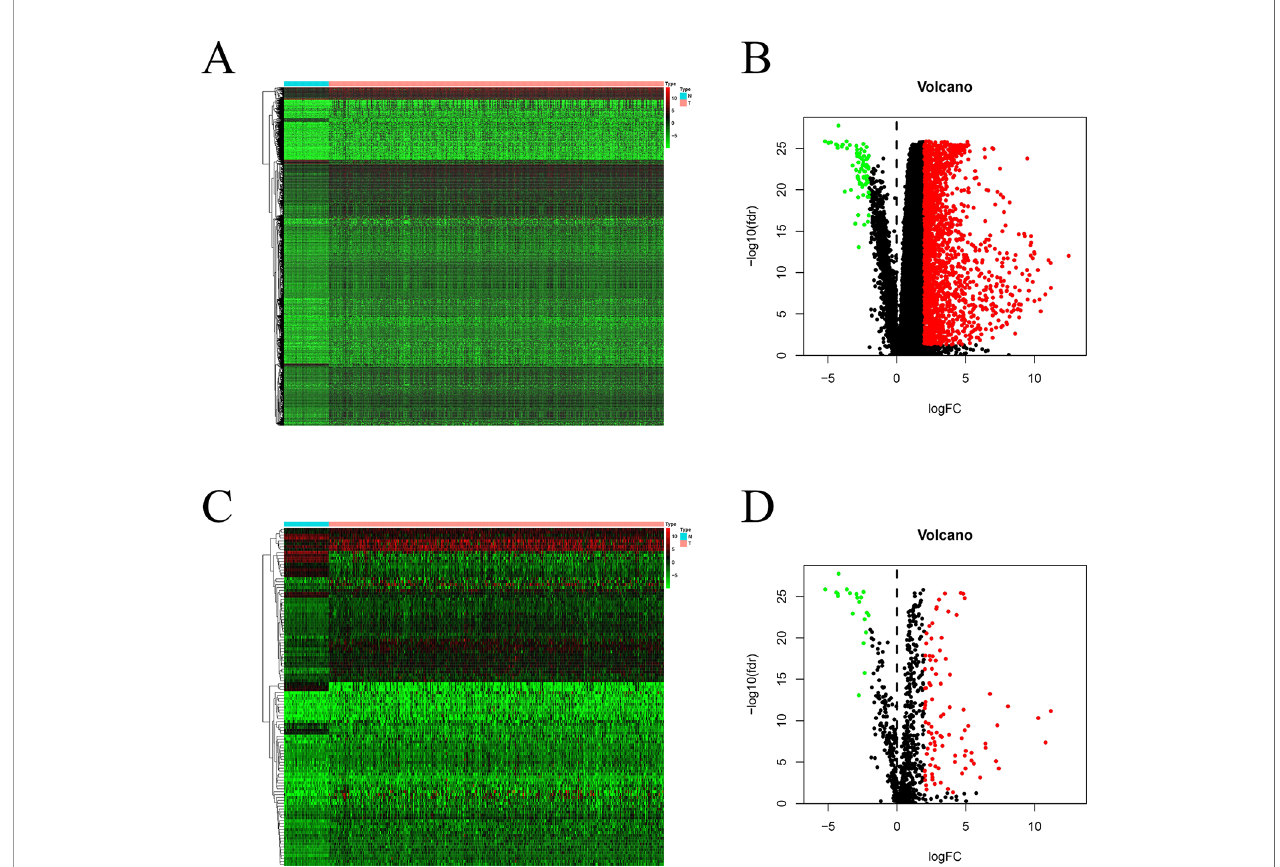
FIGURE 1 | DEGs and DEIRGs in patients with HCC: Heatmap (A) and volcano plot (B) of DEGs in HCC and adjacent non-cancer liver tissues. Heatmap (C) and volcano plot (D) of DEIRGs in HCC and adjacent non-cancer liver